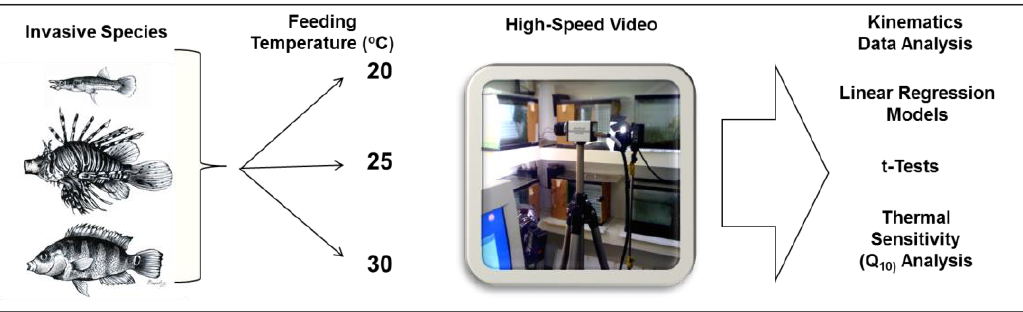
Figure 1. Diagram depicting the experimental design investigating the effects of environmental temperature on the kinematic velocity to reach maximum gape, hyoid depression, cranial rotation, and lower-jaw rotation. Four individuals of each invasive species Belonesox belizanus , Pterois volitans , and Cichlasoma urophthalmus were filmed while feeding on live-fish prey at 20 °C, 25 °C, and 30 °C using high-speed video. The best four films of each individual feeding at each temperature were digitized to measure the four kinematic velocities stated above and to calculate Q10 values. Kinematic velocities and Q10 values were subjected to the appropriate statistical tests to determine the effects of temperature on prey-capture performance.